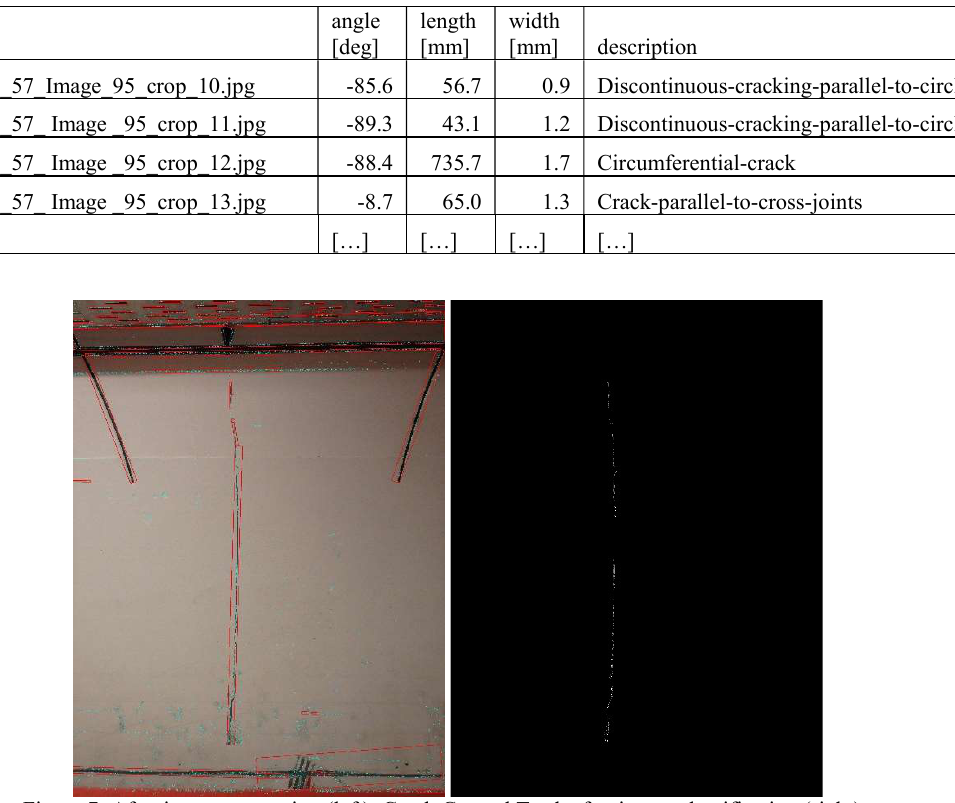
Figure 7: After image processing (left), Crack Ground Truth after image classification